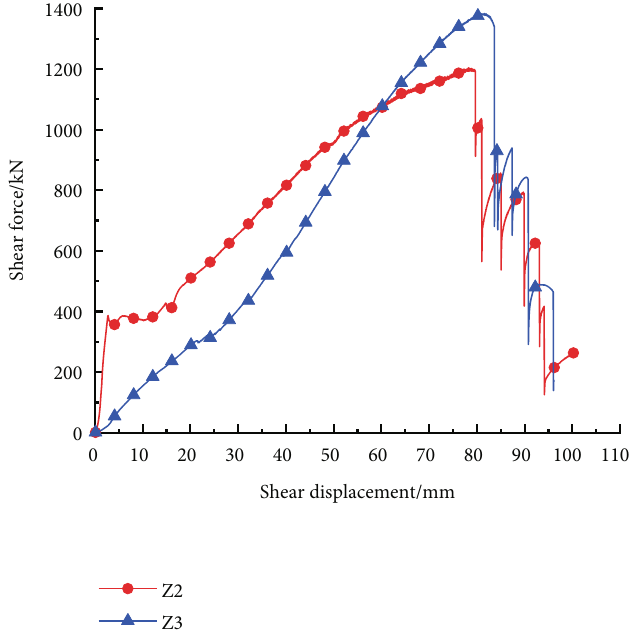
Figure 16: In fl uence of pretightening force on the shear resistance of supporting